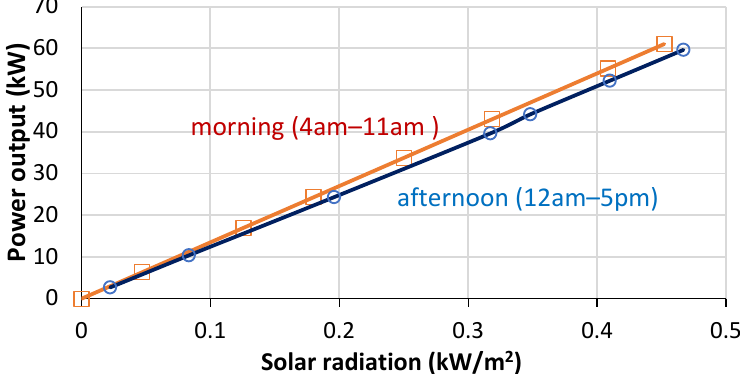
Figure 7. Electricity production (kW) by the PV array system on 31 June.